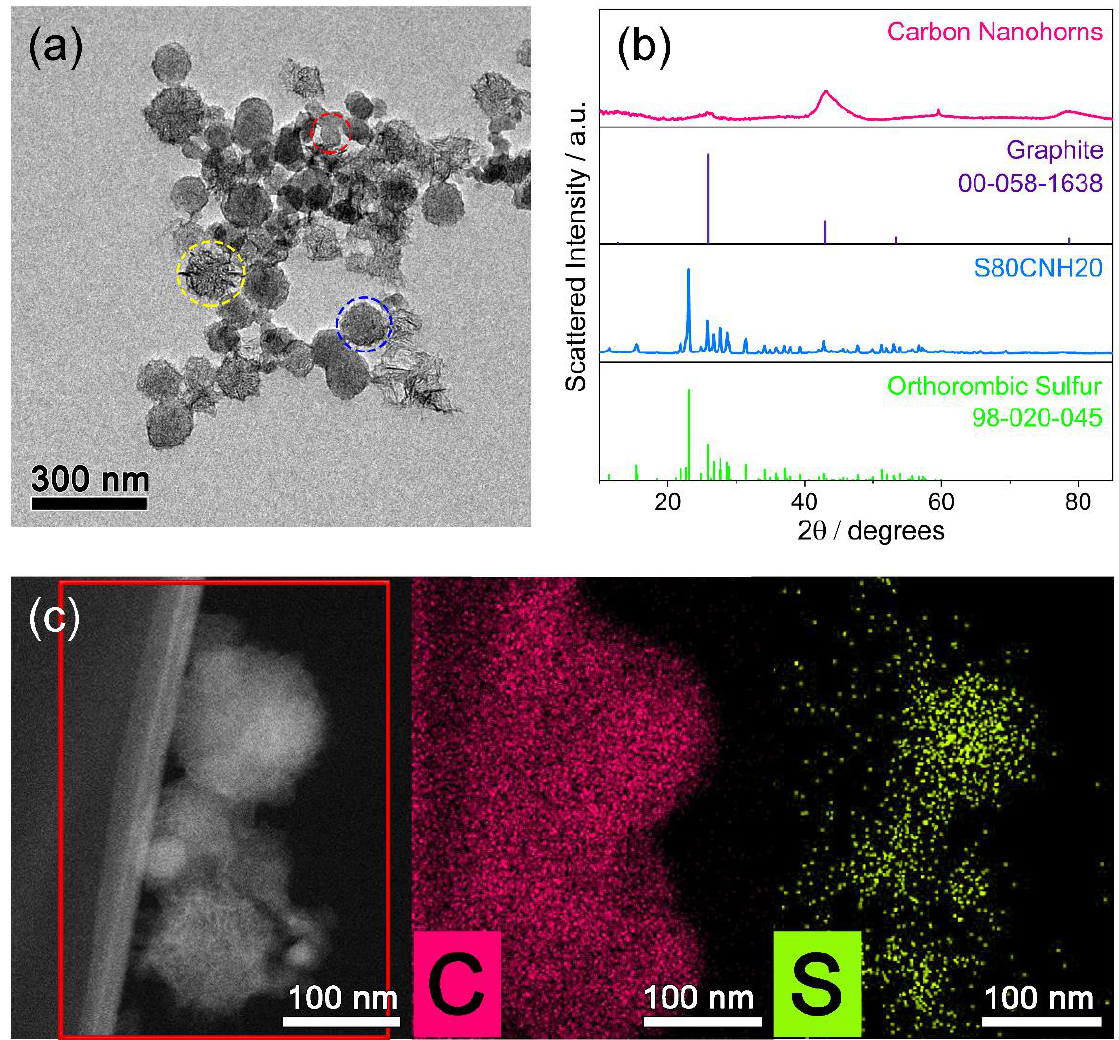
Figure 2. ( a ) TEM image of single-walled carbon nanohorns: dahlia-like (yellow dashed circle), bud-like (blue dashed circle), and seed-like (red dashed circle) structures. ( b ) XRD spectrum of carbon nanohorns (pink line), reference pattern of graphite (ICCD: 00-058-1638, purple bars), sulfur–carbon nanohorn composite spectrum (light blue line), and reference pattern of orthorhombic sulfur (ICDD: 98-020-045, green bars). ( c ) TEM image and STEM-EDS maps of S80SWCNH20 active material.